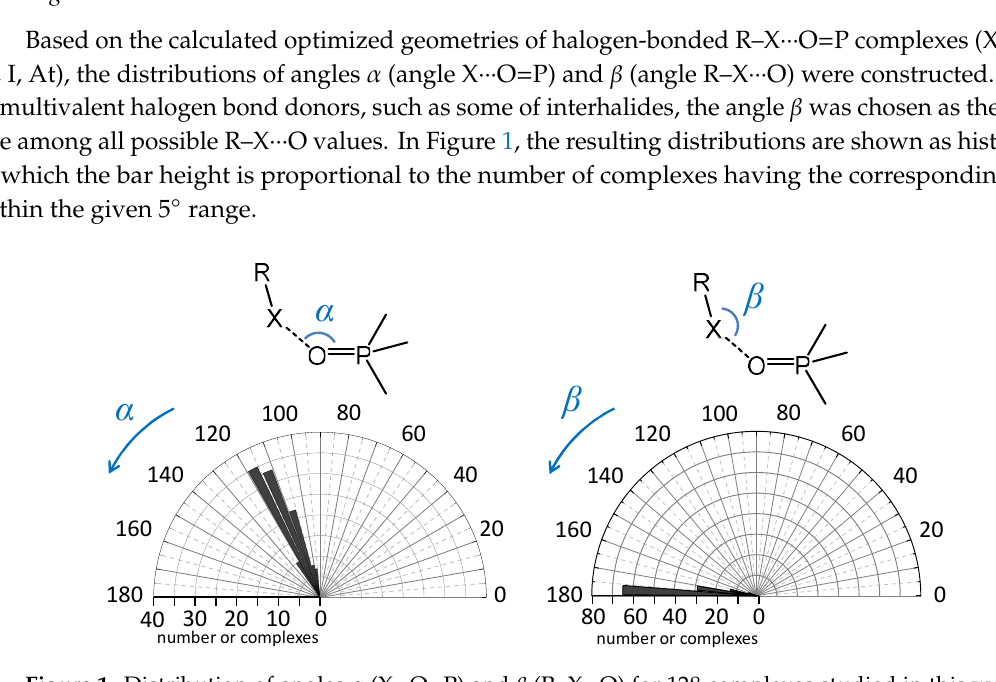
Figure 1. Distribution of angles α (X ··· O = P) and β (R–X ··· O) for 128 complexes studied in this work (X = F, Cl, Br, I, At). Histogram bars are taken every 10 ◦ for α and every 5 ◦ for β . The values of angle lie primarily in the range 100–120 . This indicates that the halogen bonds